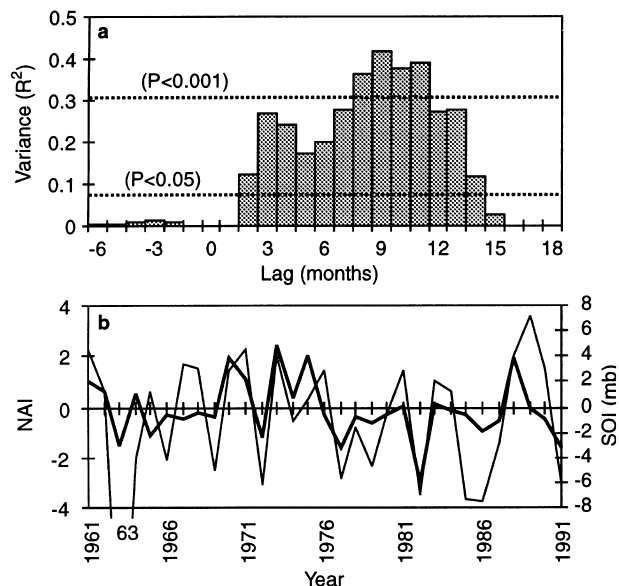
Fig. 3. a Results of a lag correlation analysis (omitting data for 1963 and 1989) between time series of the NAI and the SOI (using separate SOI series for separate months in each year), showing the variance in the SOI explained by the NAI, when the latter index (centred on February) led the SOI by up to 18 months, or lagged it by up to 6 months; b Superimposed time series of the NAI ( light line ) (the 1963 value of ) 12 being o(cid:128) scale), and the November SOI series ( heavy